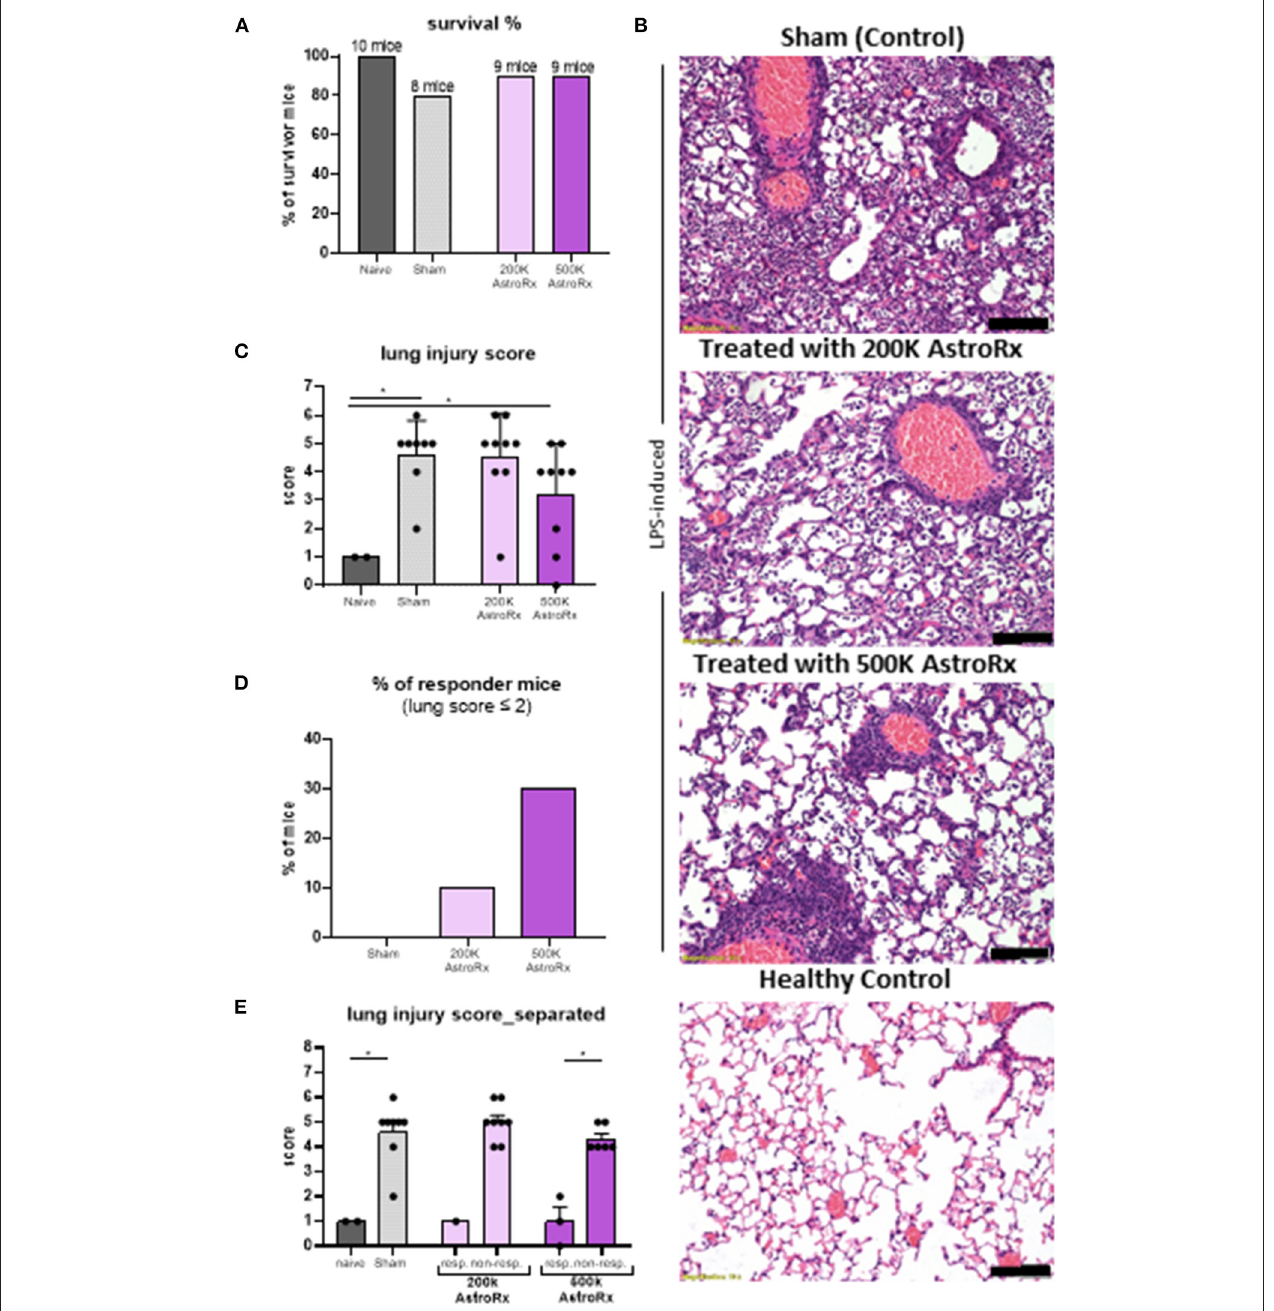
FIGURE 2 | The AstroRx cells alleviate lipopolysaccharide (LPS)-induced pulmonary inflammation and fibrosis. (A) The survival rate of animals treated with Plasmalyte (sham) and AstroRx cells (200K or 500K per animal). (B) H&E staining of lung sections from top to bottom: LPS-induced treated with vehicle (PlasmaLyte), LPS-induced treated with 200K AstroRx cells, LPS-induced treated with 500K AstroRx cells, or healthy controls (no-LPS). (C) An analysis for acute lung injury (ALI) was performed using a severity scoring scale of 0–2 (20 fields per animal were analyzed), based on the American Thoracic Society Documents, 2011 (37). (D,E) According to the lung score, the mice were categorized into responders (lung score ≤ 2) and non-responders (lung score > 2), also considering the mice that had died from ARDS ( n = 10), the results are expressed as mean ± SEM. Mann–Whitney comparison test. (C,D) Naïve vs. sham: * p = 0.0222, (C) sham vs. 500k: * p = 0.0309, (E) 500k responders vs. non-responders: * p = 0.0119, * p < 0.05. Scale bar: 100 µ